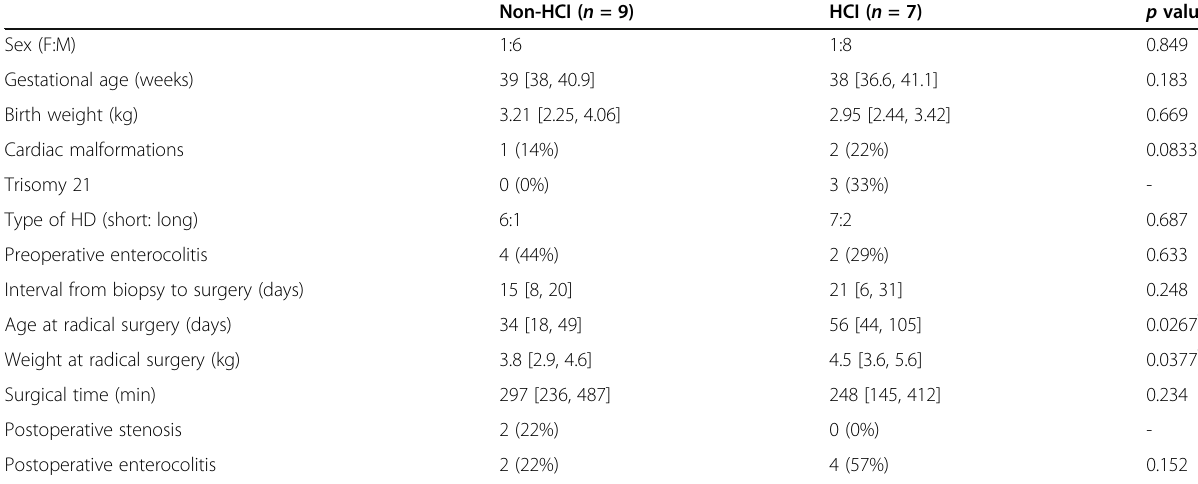
Table. 2 Comparison of background and perioperative factors between the non-HCI and HCI groups